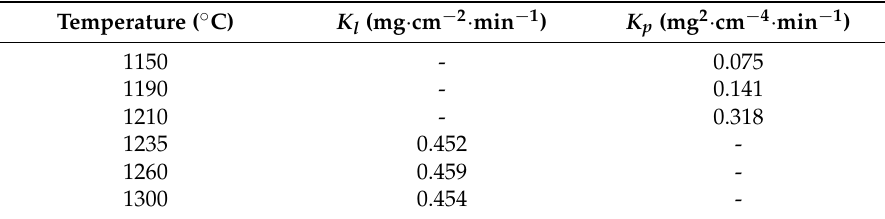
Table 3. Oxidation kinetics